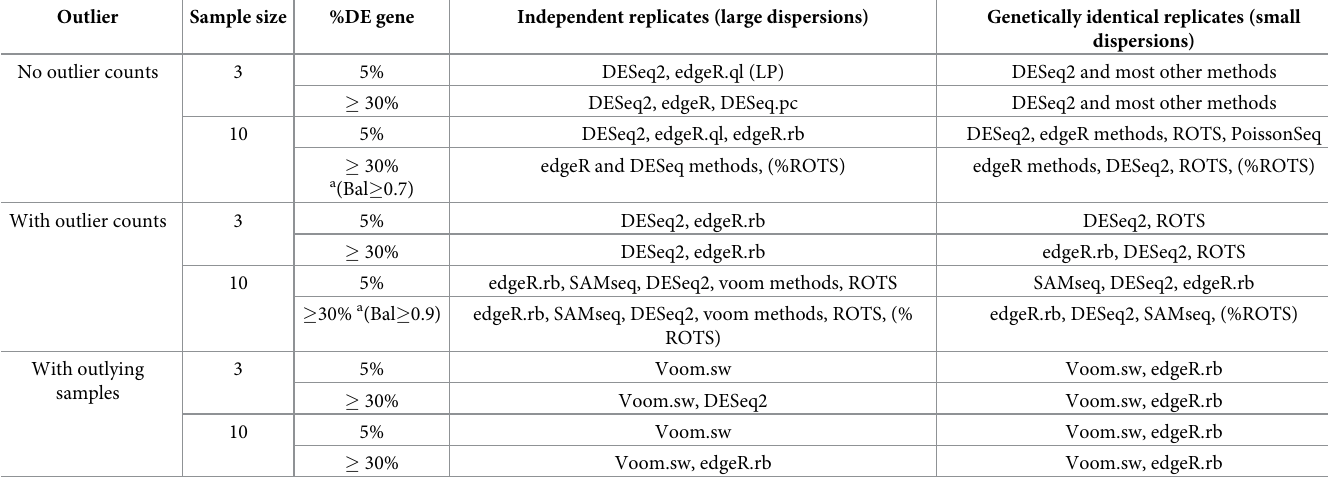
Table 2. Recommended methods for DE analysis of biological replicate RNA-seq data (simulation results).